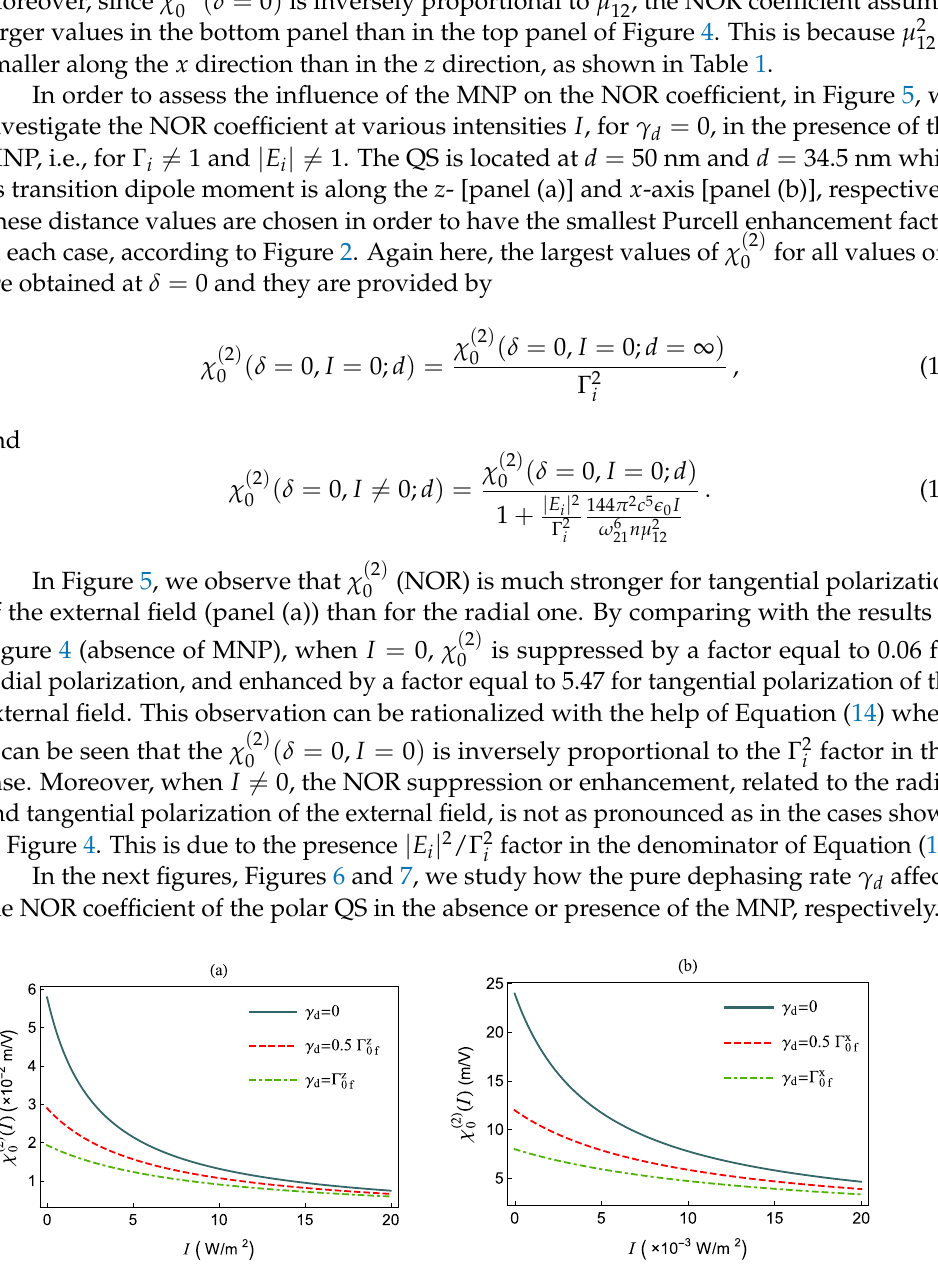
( 2 ) ( δ = 0 ) as a function of intensity I , in the absence of the MNP and for various values of Figure 6. χ 0 γ d . The QS transition dipole moment is along the z -axis ( a ) and x -axis ( b ),